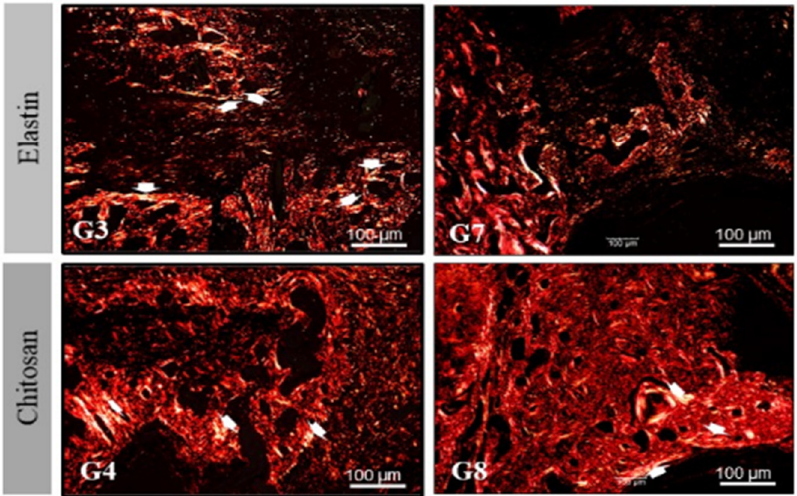
Figure 5. Polarized light analysis of the extracellular matrix in the surgical areas of the groups studied (G1–G8). The collagen fibers exhibited good birefringence in all groups but were disorganized in the alcoholic groups (G5–G8), with yellow birefringence transacting to green (white arrow). Bar: 100 µm.